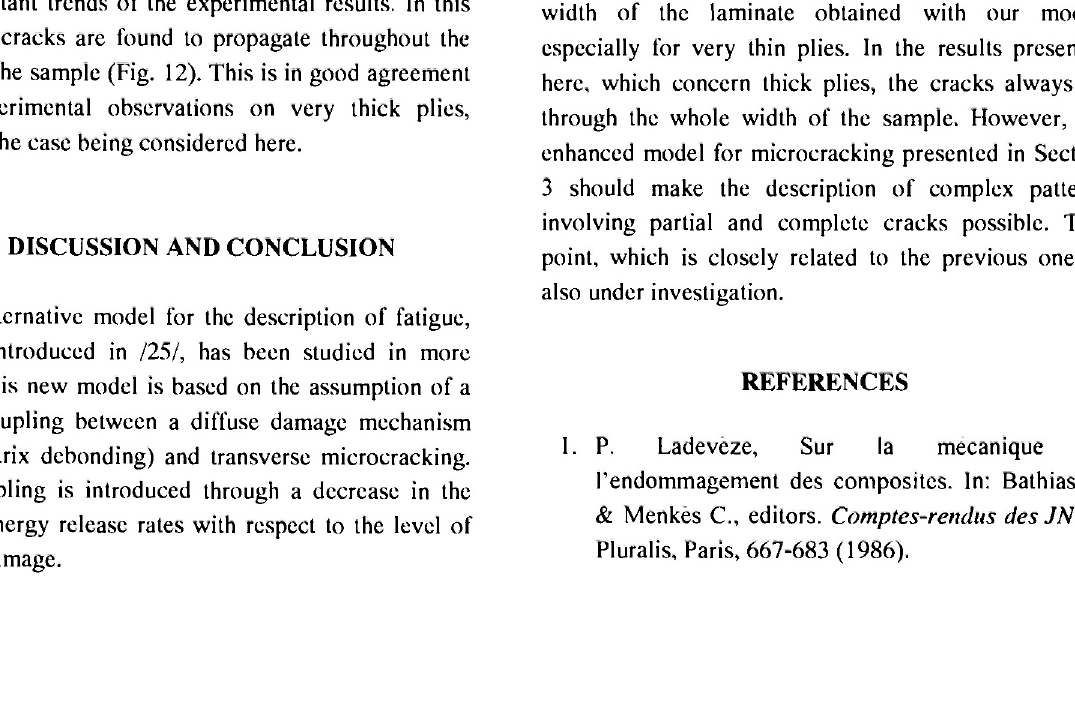
Fig. 12: Comparison of the calculated microcracking rates and experimental observations on the edge (represented by symbols) for a [0/90 s /0] laminate under cyclic loading at 1.1 F 2